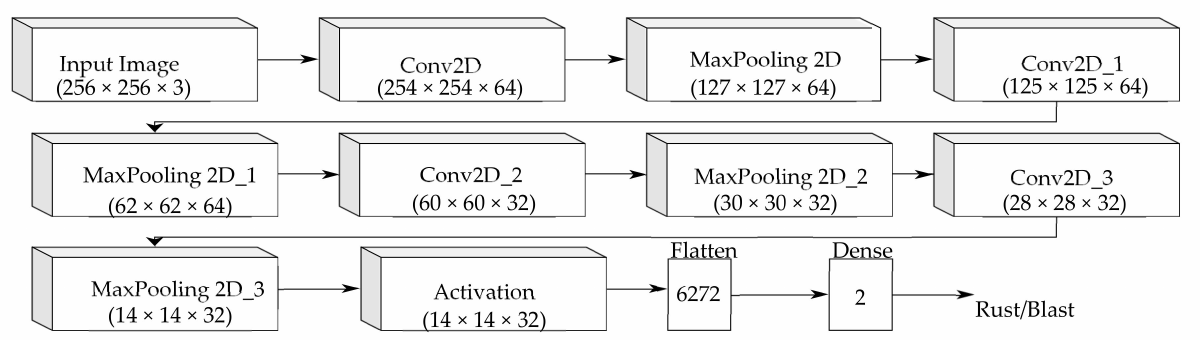
Figure 4. The architecture of the ‘Custom-Net’